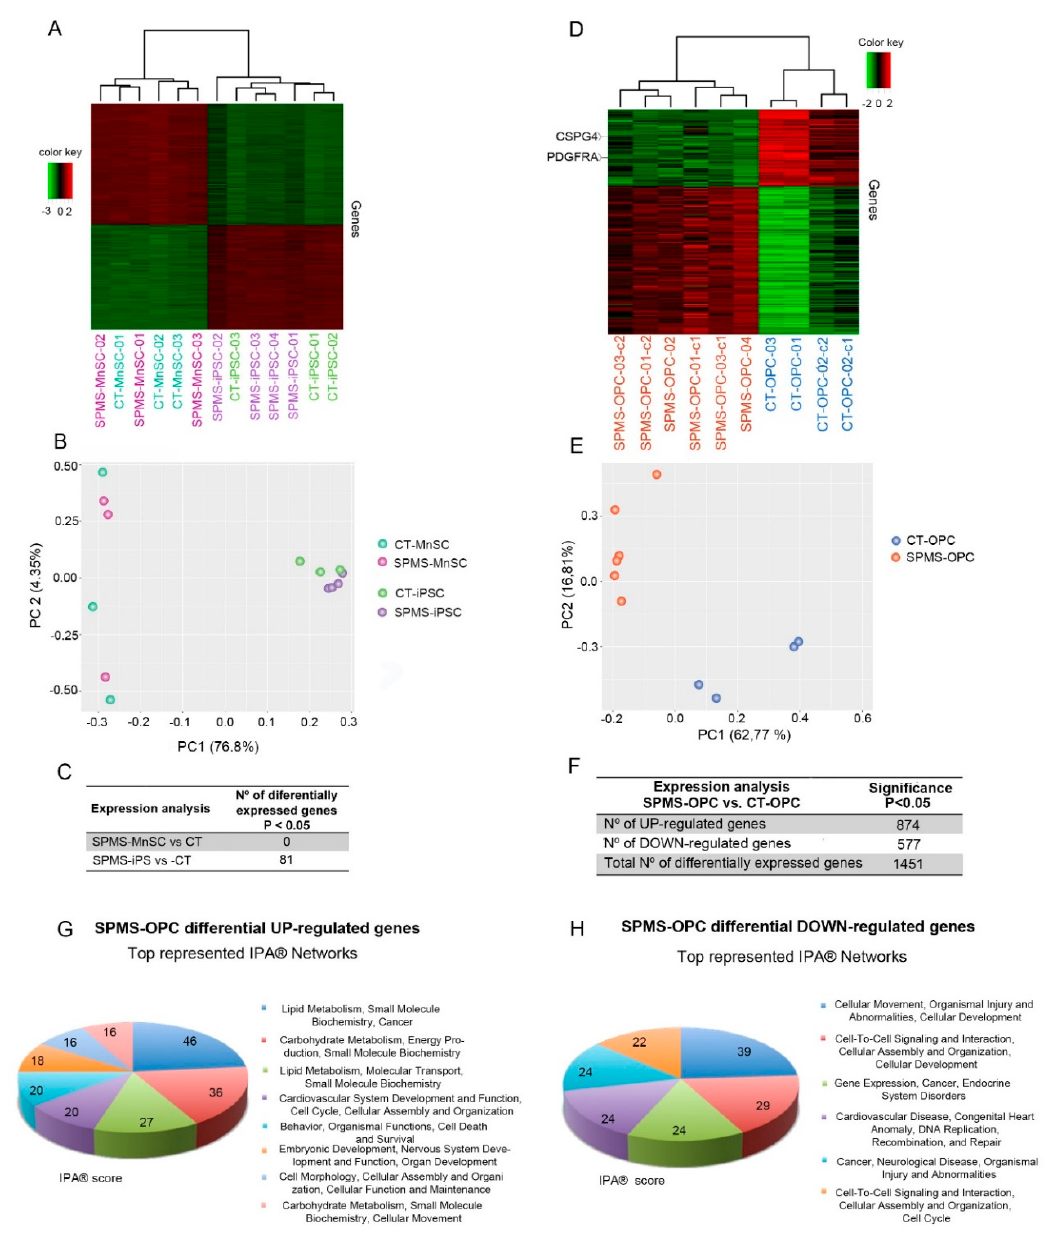
Figure 3. Transcriptomic di ff erences in SPMS-derived cells arise after di ff erentiation into early oligoprogenitor cell (OPC)-like cells. ( A ) Correlation heatmap showing the clustering of SPMS- and CT-derived somatic cell lines and isogenic generated iPSCs using high-throughput array-based expression data. The Euclidean distance and complete agglomeration method were used to compute the heatmap dendrogram. Correlation was computed with Pearson’s method. ( B ) Principal component analysis (PCA) using expression data, as in Figure 3A. ( C ) Di ff erentially regulated genes between SPMS and CT groups using somatic or pluripotent cells ( p -value adjusted by false discovery rate (FDR) < 0.05). ( D ) Correlation heatmap showing the clustering of SPMS- and CT-derived early OPC-like cells using RNA expression (array-based) data, as in Figure 3A. ( E ) PCA analysis using expression data of early OPC-like cells. ( F ) Di ff erentially regulated genes between SPMS- and CT-derived OPC-like cells ( p -value < 0.05). ( G , H ) Identification of the top represented significantly activated networks using Ingenuity ® Pathway Analysis (IPA ® ) based on upregulated ( G ) or downregulated ( H ) genes in SPMS-derived early OPC-like cells.